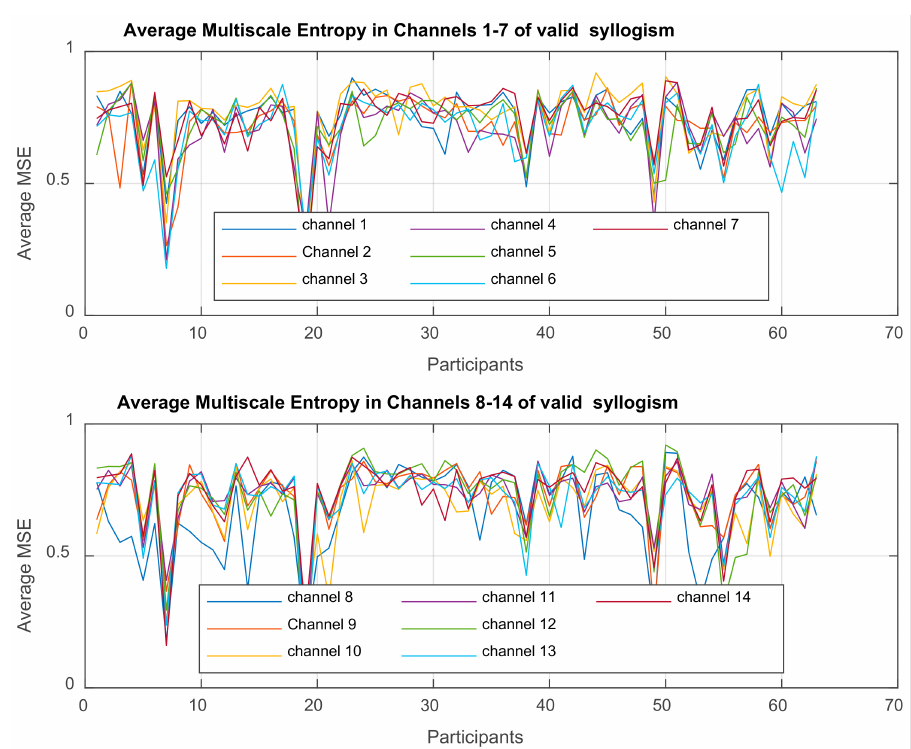
Figure 10. Time series of average MSE values at channels per subject, extracted from EEGs recorded at participant’s scalp, when they are exposed in a cognitive load induced by a valid syllogism.